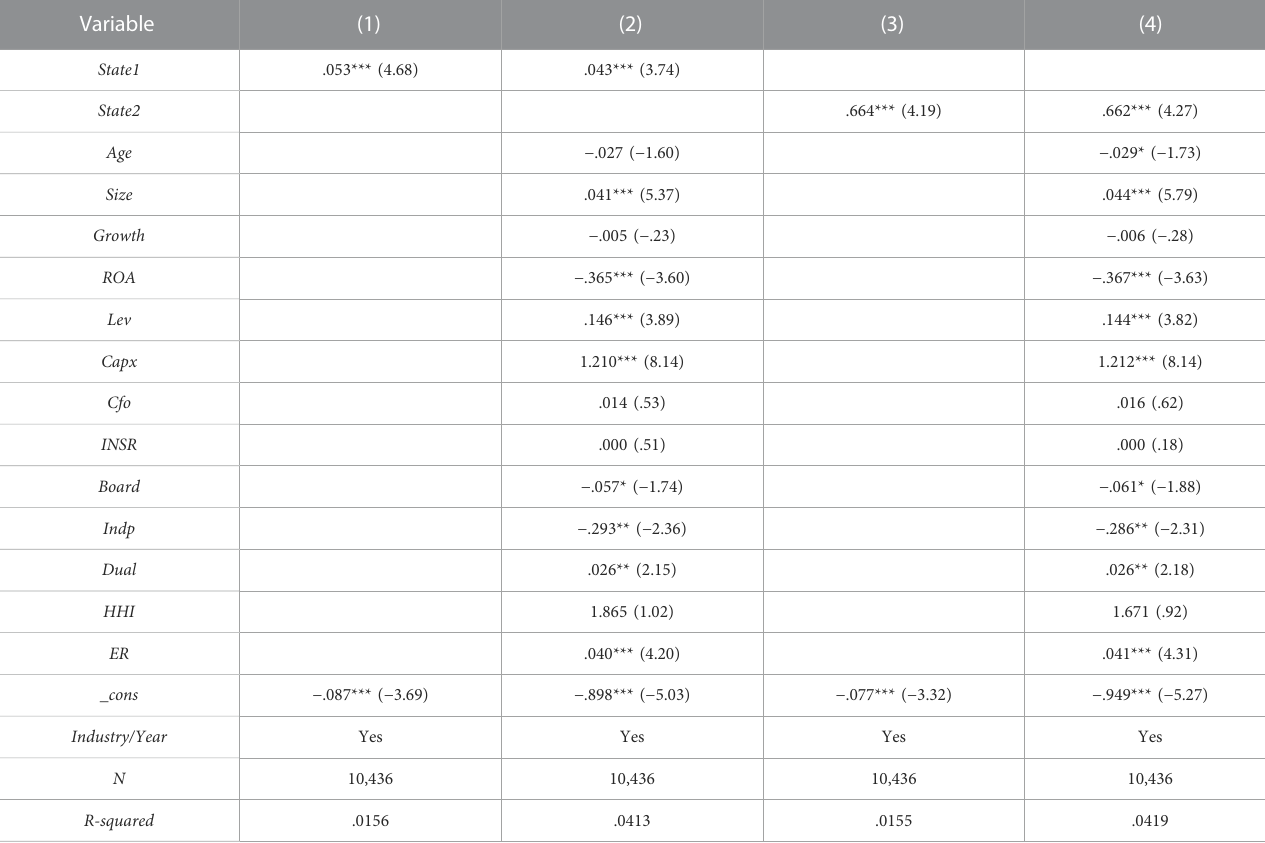
TABLE 4 Analysis of main regression results.